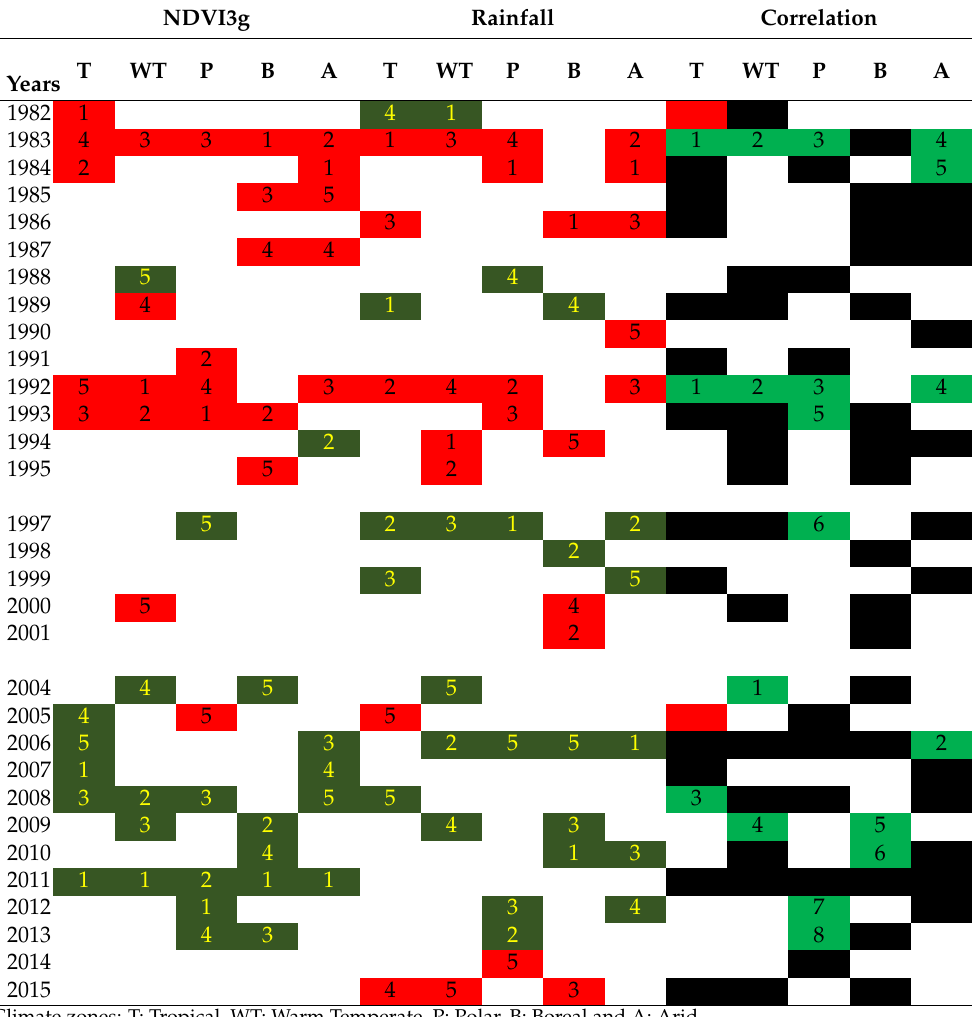
Table 1. The considered special periods during which NDVI3g and rainfall had their highest (five years) and lowest (five years) values and their correlation. Fir green represents high, and red represents low. The numbers 1 to 5 indicate high to low Normalized Difference Vegetation Index (NDVI) and precipitation values (for fir green) and low to high NDVI and precipitation values (for red) in each climate zone. In the correlation column, green represents a positive correlation, black is no correlation, and red is a negative correlation. NDVI3g Rainfall Correlation T WT Years